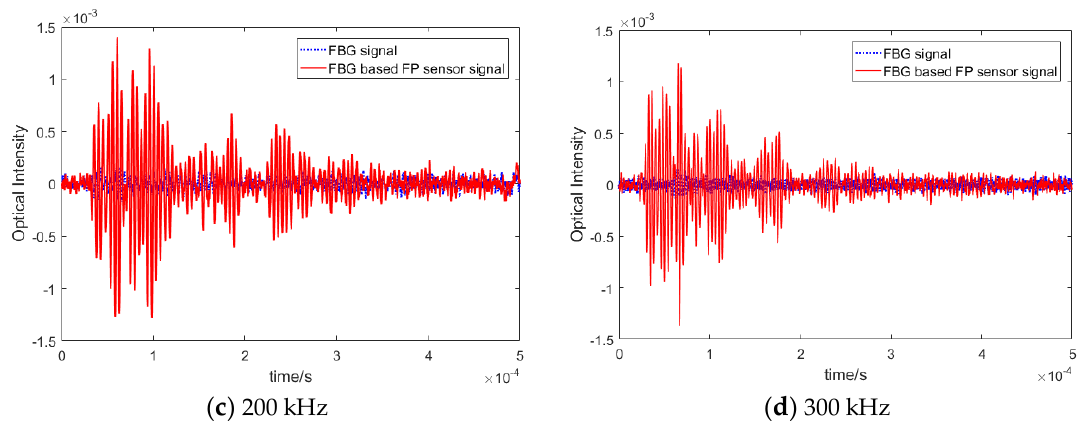
Figure 18. Comparison of a residual signal recorded by FBG-based FP and FBG sensors for different frequencies.